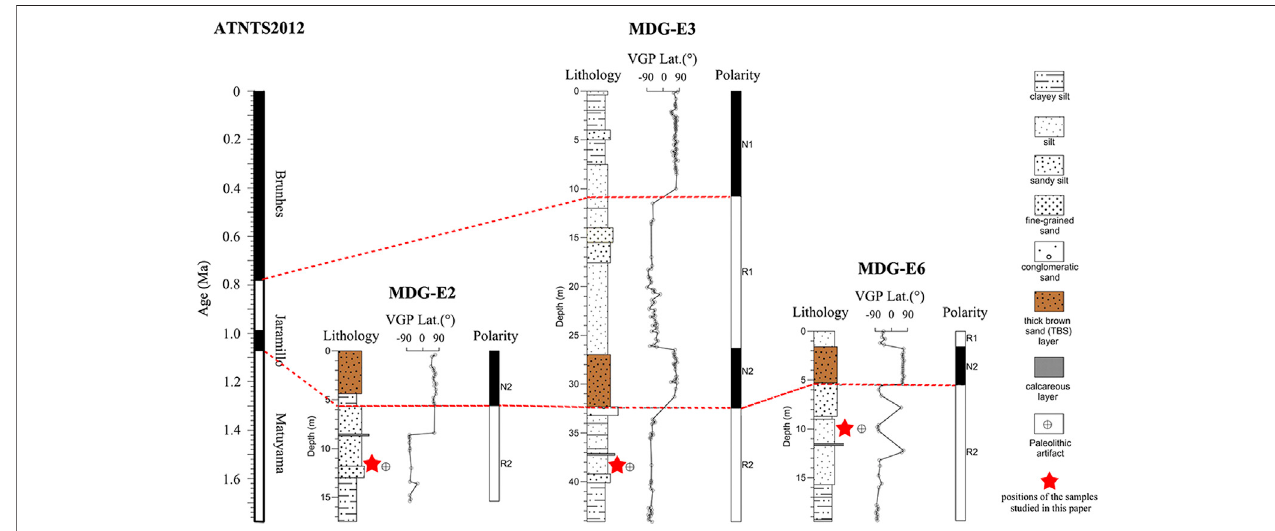
FIGURE 2 | Lithostratigraphy and magnetic stratigraphy of MDG-E2, MDG-E3 and MDG-E6, and positions of the samples studied (excluding one sample from MDG-E7) (Hilgen et al., 2012; Pei et al., 2019).